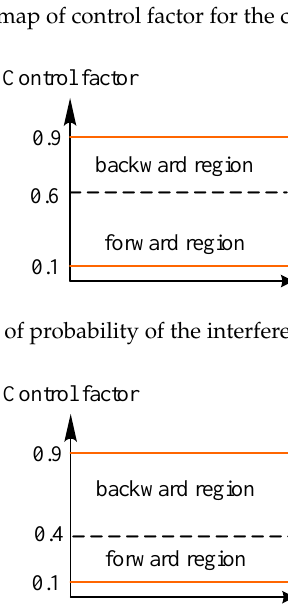
Figure 5. Variation of probability of 𝑠𝑖𝑔𝑛 = −1 .